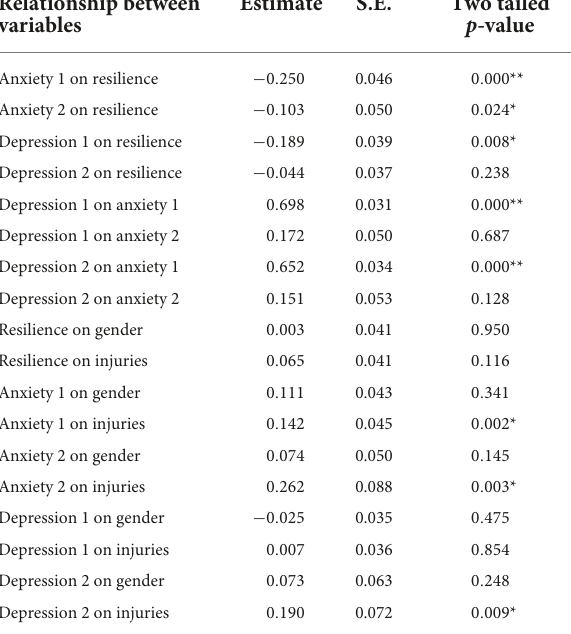
TABLE 4 Estimate, standard error, and two-tailed p -value for analyzed